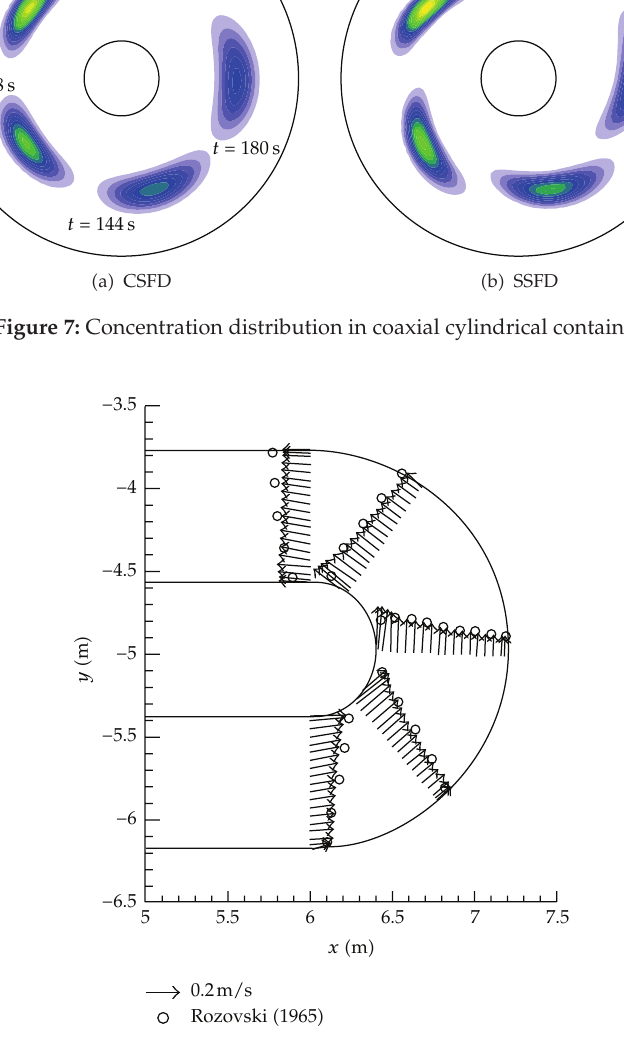
Figure 8: Comparison between computed and measured flow fields in Rozovski’s